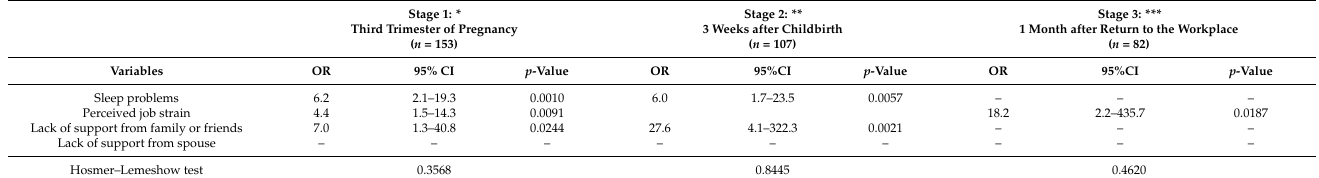
Table 4. Multiple logistic regressions of perinatal depressive symptoms (EPDS ≥ 13) during the three stages for risk factors including sleep problems, perceived job strain, and important support from others among participants, adjusted for other